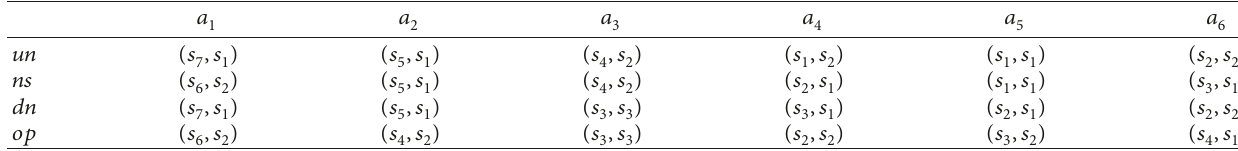
Table 2: Decision matrix by second expert.